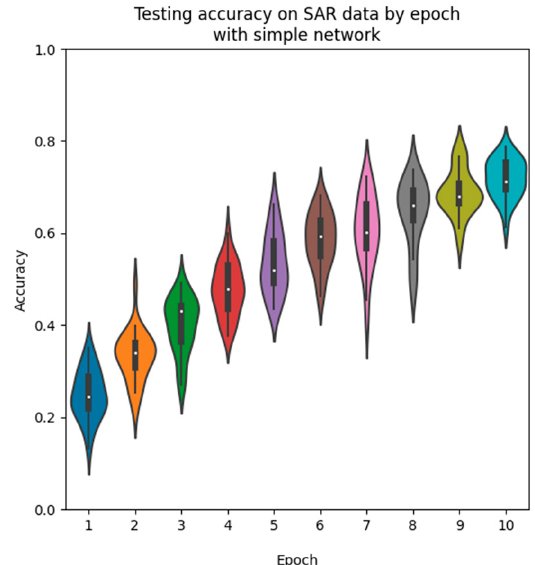
Figure 10. Simple net SAR-only accuracy distributions during training by epoch.